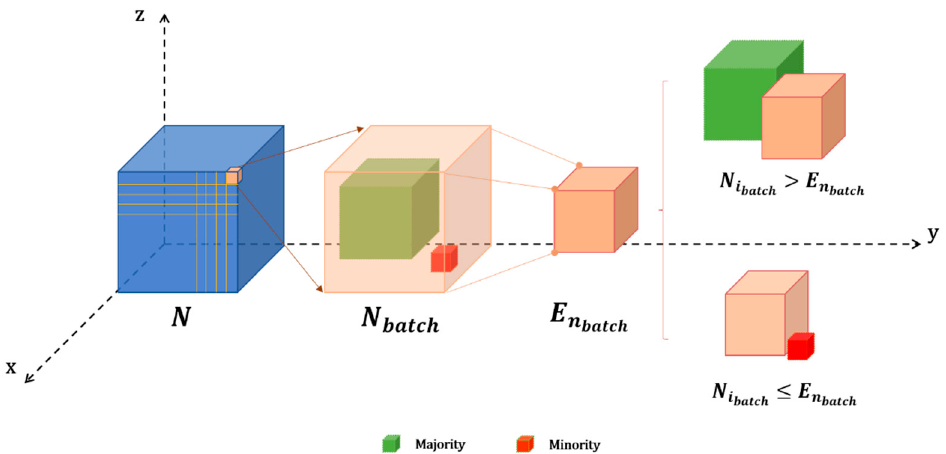
Figure 8. N batch is a subspace of the sample space N . Within this subspace, the category with a larger Figure 8. 𝑁 (cid:3029)(cid:3028)(cid:3047)(cid:3030)(cid:3035) is a subspace of the sample space 𝑁 . Within this subspace, the category with a sample space than E nbatch is the majority class, otherwise it is the minority larger sample space than 𝐸 (cid:3041)(cid:3029)(cid:3028)(cid:3047)(cid:3030)(cid:3035) is the majority class, otherwise it is the minority class .